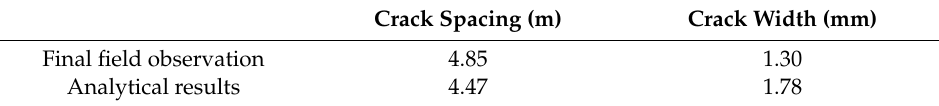
Table 4. Comparison of the field-measured and predicted crack spacing and crack